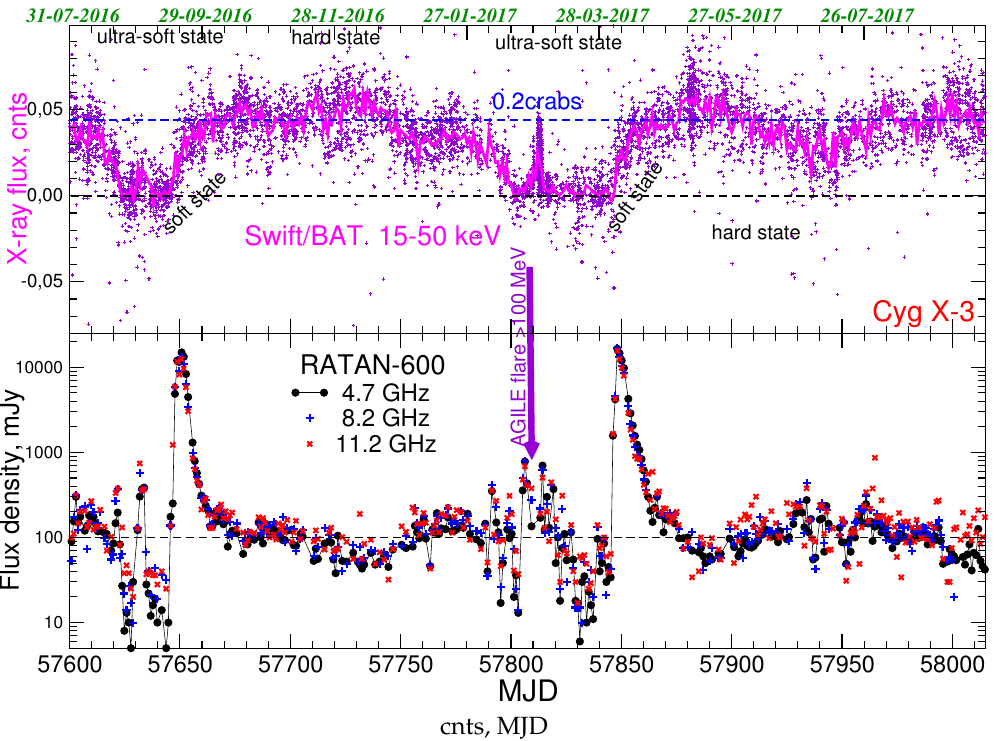
Figure 1. The light curves at 4–11 GHz with RATAN-600 ( bottom ) and at 15–50 keV with Swift/BAT ( top ) of Cyg X-3 during 2016–2017. The characteristic X-ray states are marked on the top plot. The detected AGILE flare ( > 100 MeV) preceded the giant flare on 1 April 2017.